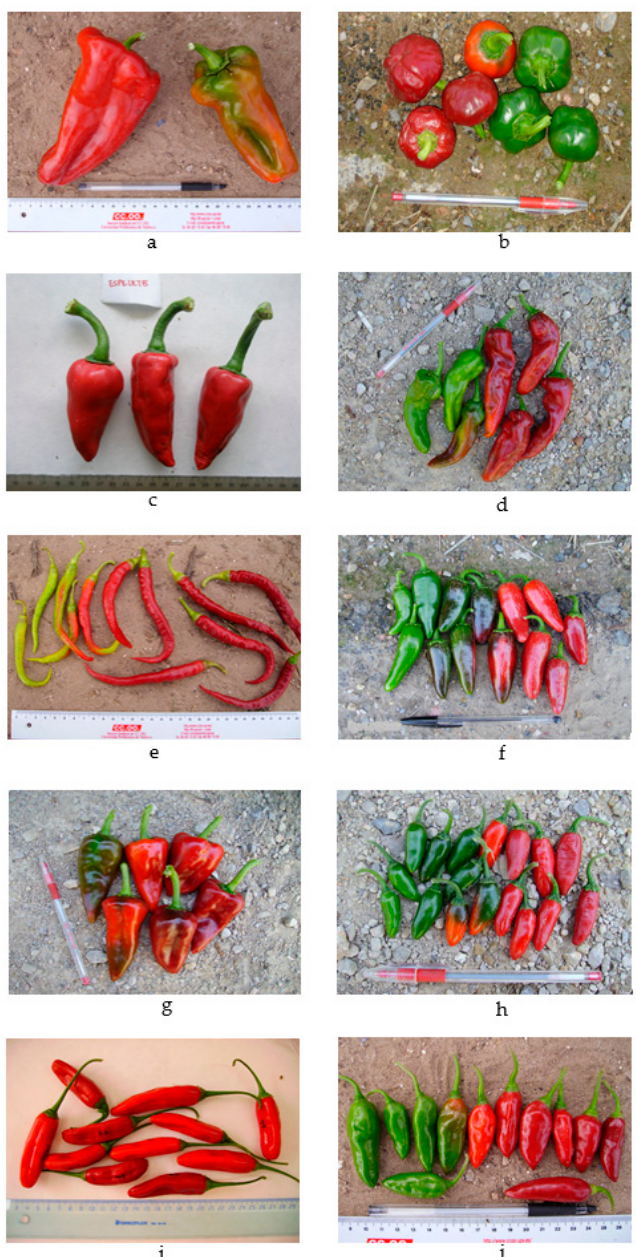
Figure 6. Fully ripe fruits of the accessions used. Rulers at the bottom are in cm (marks between two numbers indicate 1 cm). The pen has a 150 mm length. In pairs, from left to right, and in descending direction: BGV10582 ( a ), Bola ( b ), Espelette ( c ), Gernika ( d ), Guindilla de Ibarra ( e ), Jalapeño ( f ), Piquillo ( g ), Serrano ( h ), C. baccatum BOL58 ( i ), and C. chinense ECU994 ( j ). Ten plants per accession and growing system were transplanted at the four true leaves stage, distributed in five blocks of two plants each. The plot was divided into five rows and all the accessions were represented by one block within each row following a randomized design within the row, with a planting frame of 1.0 × 0.5 m between rows and within the row, respectively. Additionally, plants remaining after transplanting were used as borders to achieve two rows of plants surrounding each side of the experimental plot. Growing conditions were as described in Ribes-Moya et al. [23,24]. Briefly, surface irriga- tion was used every 8 to 10 days, depending on evapotranspiration. For the organic sys- tem, organic sheep manure (4 kg m − 2 ) was spread as fertilizer at the beginning of the sea- son. Pest control was not necessary because of the presence of natural predators, and weeds were monthly removed by hand. For conventional cultivation, one application of